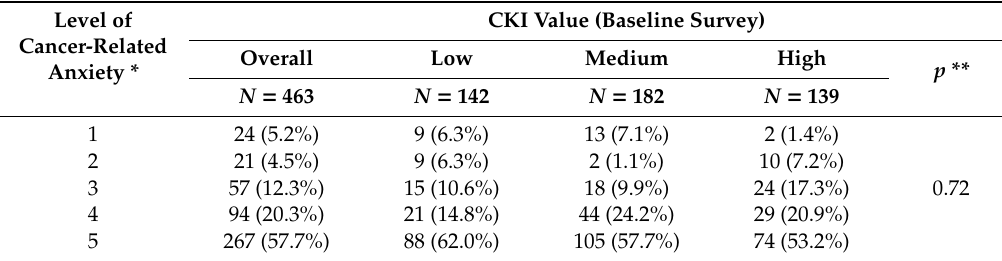
Table 1. Descriptive statistics of the variable assessing di ff erences in the severity of cancer-related anxiety in the subgroups defined by the tertile distribution of Cancer Knowledge Index (CKI)